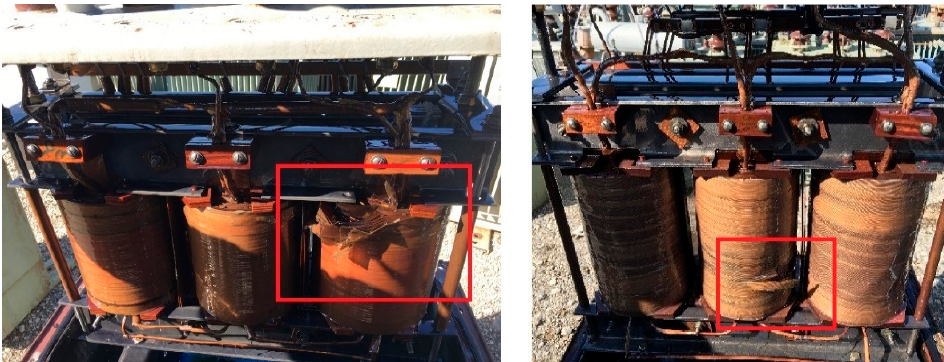
Figure 1. Deteriorated solid insulation of distribution transformers.